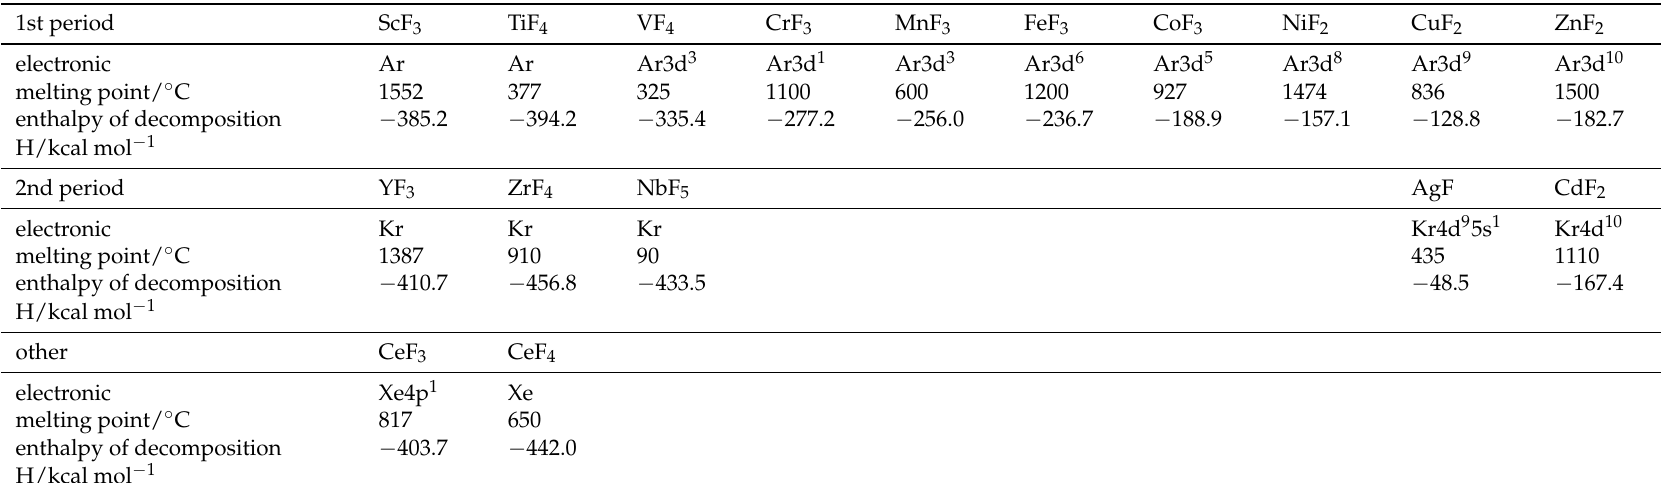
Table 4. Relevant transition metal fluorides data. Enthalpy values (for the solid phase) from the Peep Database